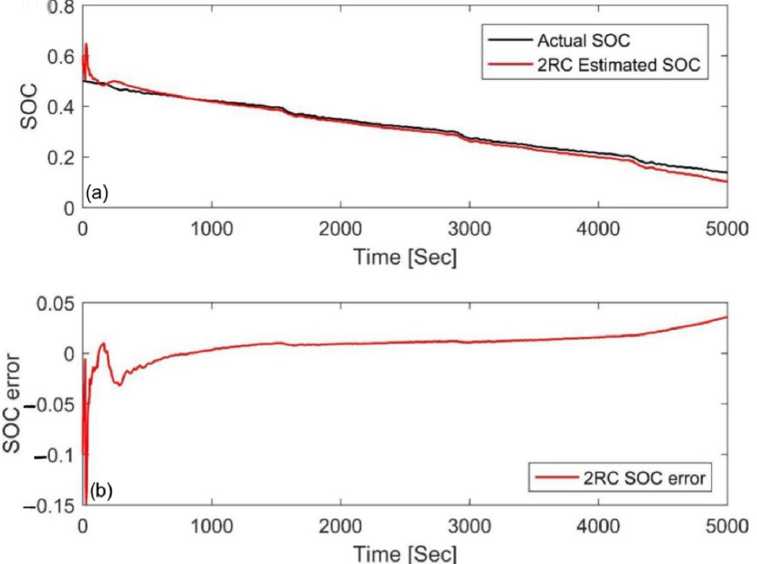
Figure 11. Estimation results at an initial SOC of 60% via the FUDS at 0 °C. ( a ) SOC estimation comparison curve; ( b ) SOC estimation error. Table 4. MAE and convergence rate at 0 °C.